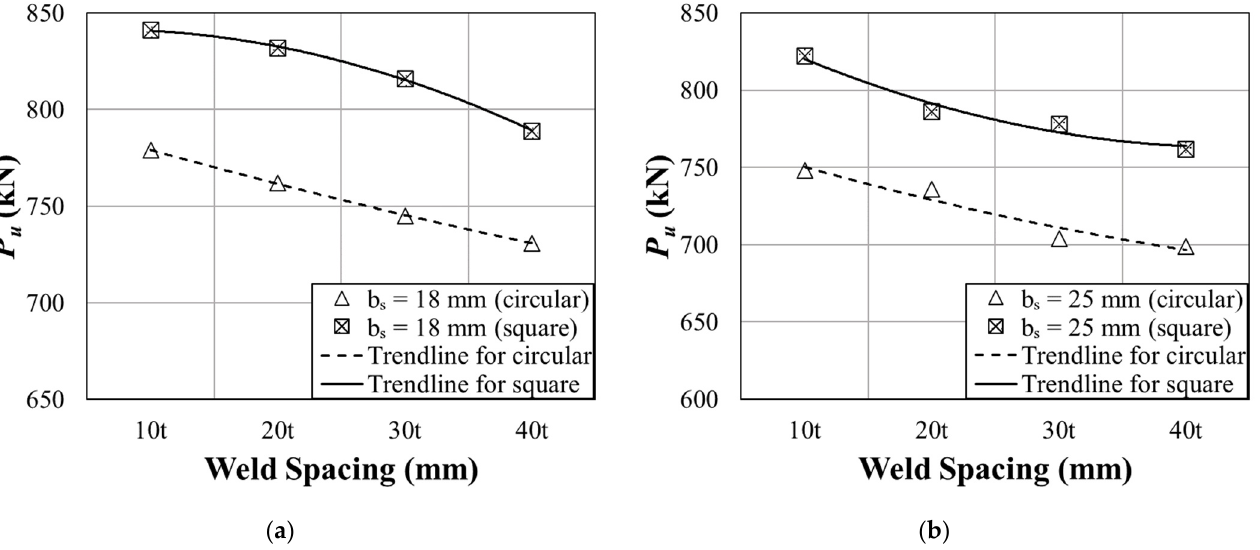
Figure 9. Effect of the weld spacing on the ultimate load of each specimens for two stiffeners’ size .